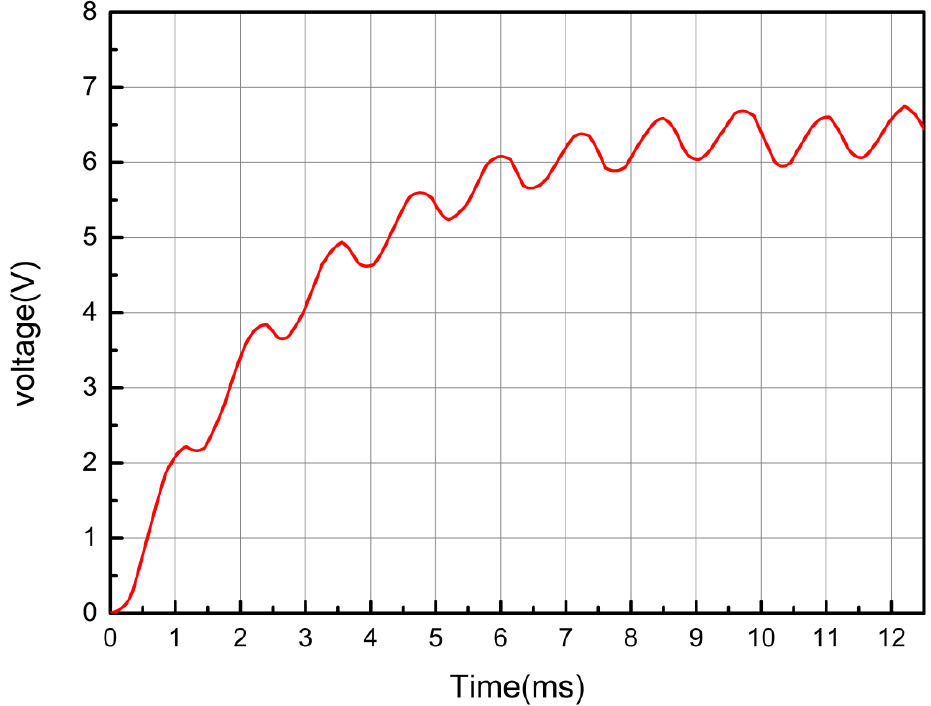
Figure 6. The voltage waveform of reference point A when value of C1 is 0.9 μF .